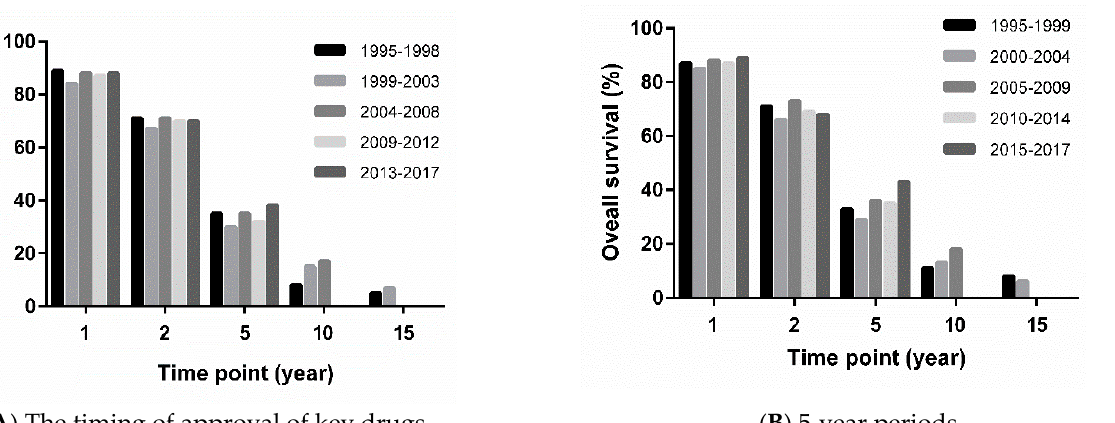
Figure 2. Overall survival rates for patients with de novo metastatic breast cancer at 1, 2, 5, 10, and 15 years after diagnosis according to diagnosis date, with dates grouped according to ( A ) the timing of approval of key drugs and ( B ) 5-year periods.